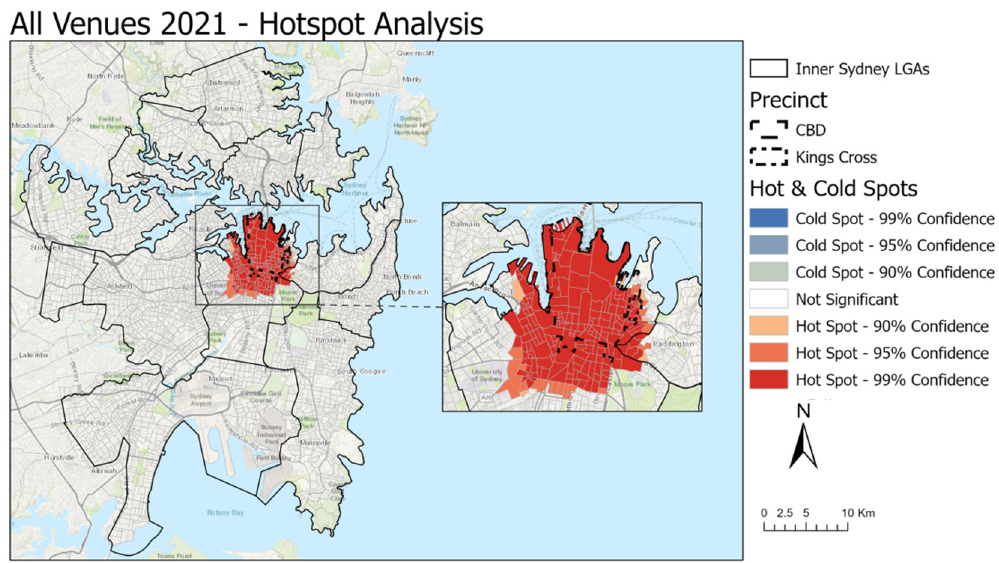
Figure 13. All venue hotspots 2021.